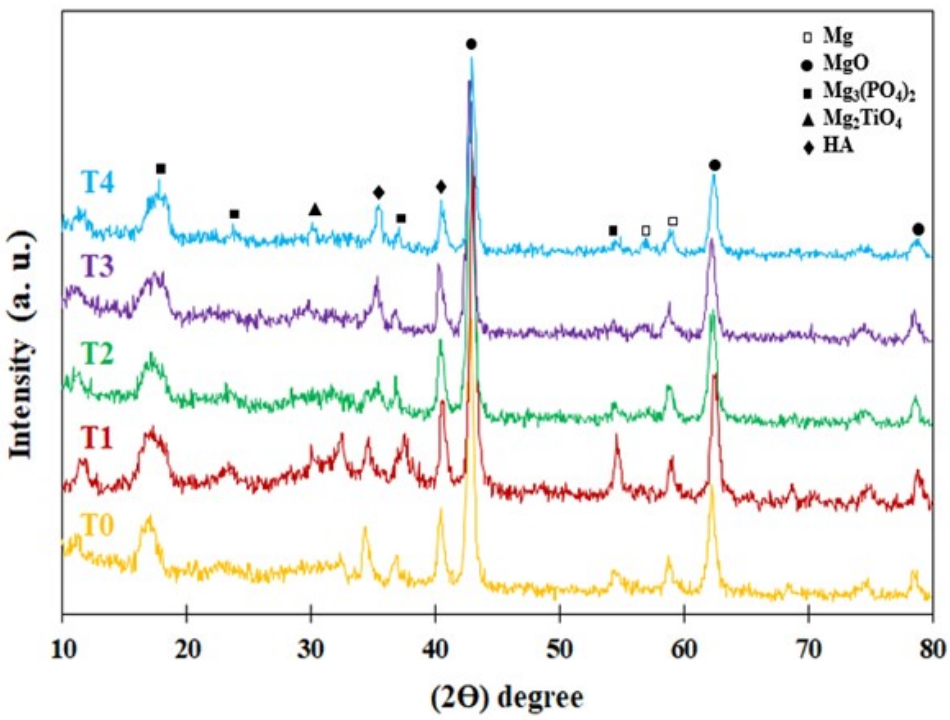
Figure 5. GXRD pattern of PEO-coated specimens.